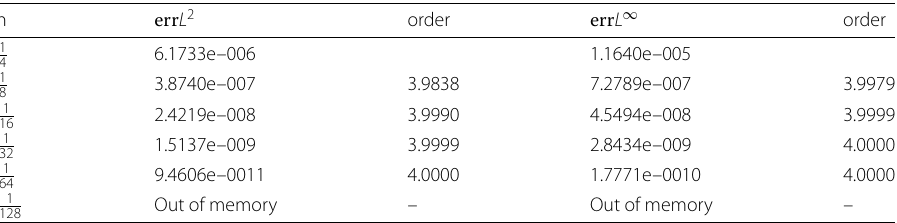
Table 3 The comparison of the l 2 -norm and the l ∞ -norm when τ 2 = h x = h y for O ( h 4 x + h 4 y ) fourth-order compact finite difference schemes in Example 2, at different values of the step size (for N = 4,8,16,32,64,128) in the x and y directions h err L 2 order